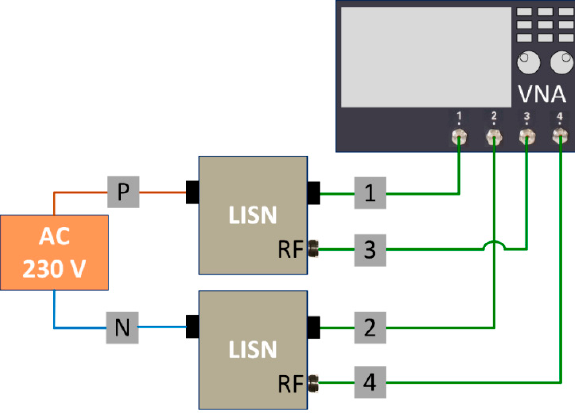
Figure 5. Characterization of the two LISNs as a four-port network.